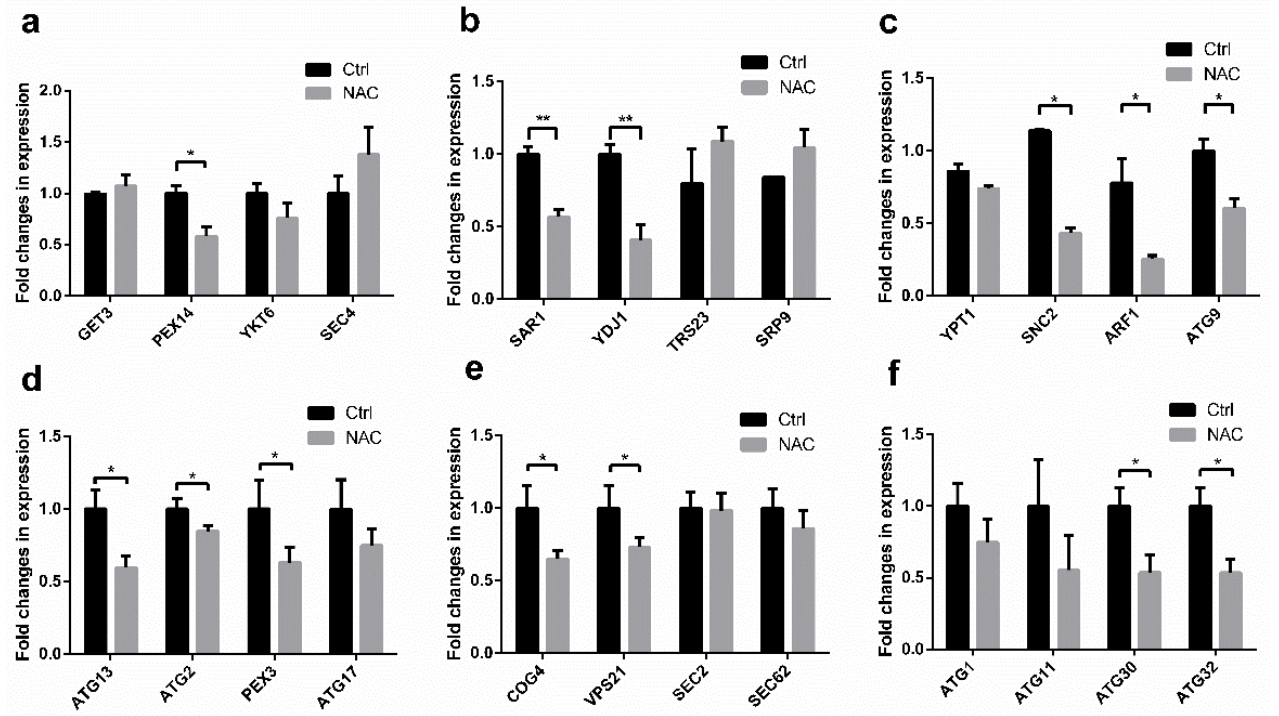
Figure 3. Effect of NAC on the mRNA expression levels of genes involved in vesicular trafficking and autophagy. ( a – c ) Relative transcription of vesicular trafficking-related genes supplemented with or without NAC. ( d – f ) Relative transcription of autophagy-related genes supplemented with or without NAC. All gene expression levels were relative to β -actin and normalized to non-NAC-treated control (Ctrl). All primers used in this study are shown in Table S1. Each bar represents the mean value from three determinations including the standard deviations. * indicates statistical significance of p < 0.05 (Marked with *) and ** represent extremely significant difference of p < 0.01 by using Student’s two-tailed t -test.